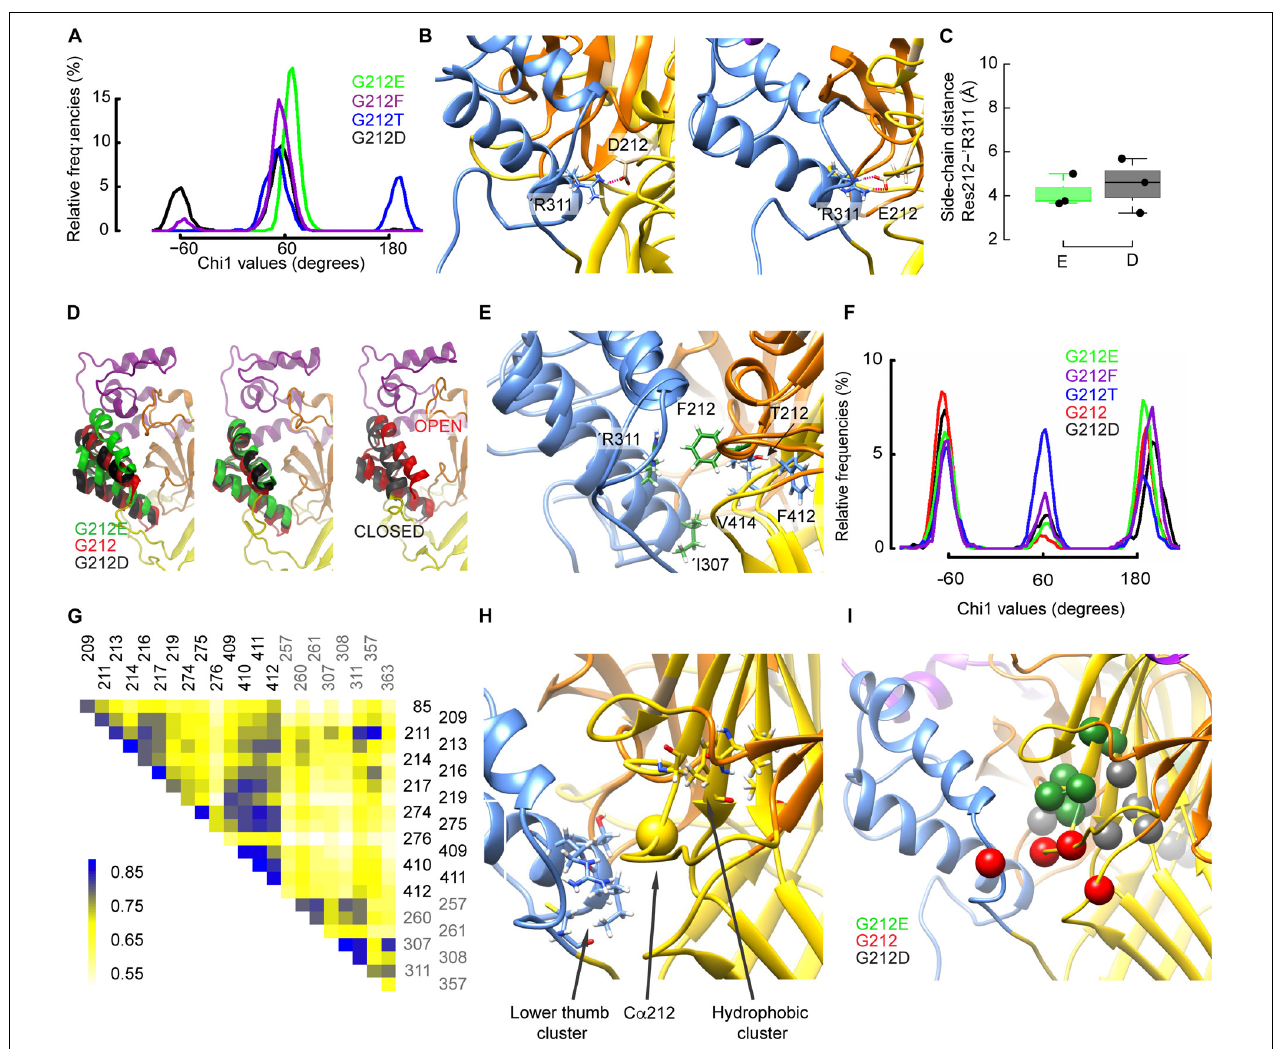
FIGURE 7 | Gly212 mutants induce conformational changes that affect desensitization. (A) Probability density of χ 1 orientations of residue 212 in the indicated mutants, from the last 150 ns of MD trajectories started from the desensitized structure. (B) Molecular representations of ASIC1a containing G212D (left) and G212E (right) showing the heavy atoms of selected residues. The ASIC domains are colored as follows: palm: yellow, thumb: blue, beta ball: orange, knuckle: cyan. Red dashed lines indicate salt bridges (C) Average distances between the side-chain atoms of G212E and G212D, respectively, and ’Arg311. (D) Comparison of the thumb helix reorientation of WT (Gly212), G212D, and G212E where the mutated residue at position 212 has a χ 1 value of ∼ -60 (left panel) or +60 (middle panel) with a superposition of the open and closed crystal structures (right panel). For the WT, a typical conformation was taken. (E) , Superposed molecular representations of G212F and G212T. Coloring as in (B) . Note how ’Arg311 is repelled by Phe212. (F) Probability density of χ 1 orientations of residue ’Asp357 in the indicated mutants, from the last 150 ns of MD trajectories, started from the desensitized structure. (G) Example of a correlated motion matrix in the vicinity of the residue 212. The matrix elements of the cross-correlation heat map are colored according to the scale bar shown on the left side of the plot. Shown here is the analysis of MD simulations based on the desensitized model of WT hASIC1a. (H,I) Molecular representation in the vicinity of the residue 212 highlighting clusters of simultaneously moving residues, as identified through cross-correlation matrix analysis. (H) Residue pairs with high cross-correlation values in all constructs. (I) residue pairs whose correlation was high with specific substitutions at position 212.